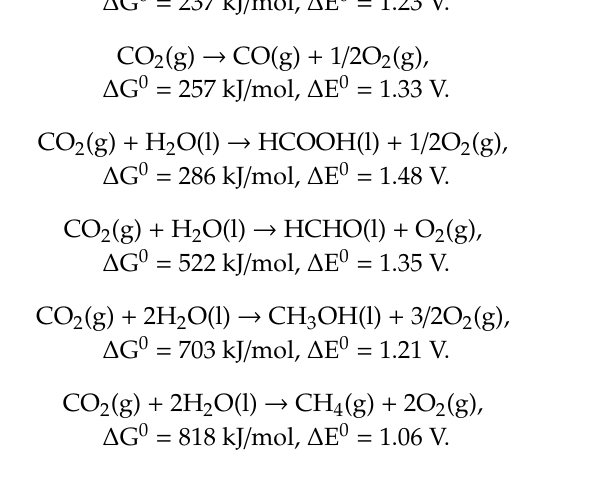
Table 1. Reduction potentials of CO 2